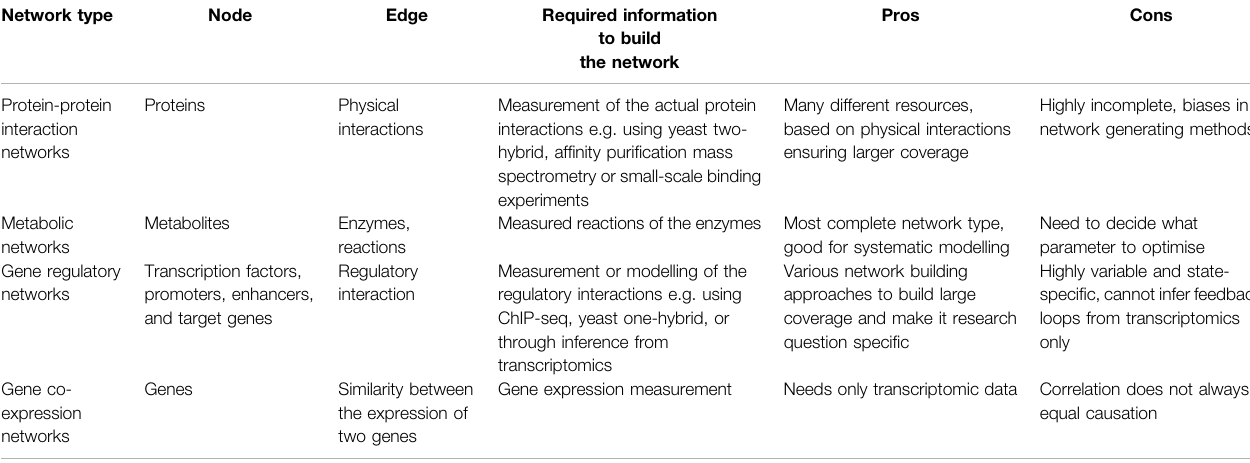
TABLE 1 | Characteristics of various network types discussed in this review and their main advantages and disadvantages. Network type